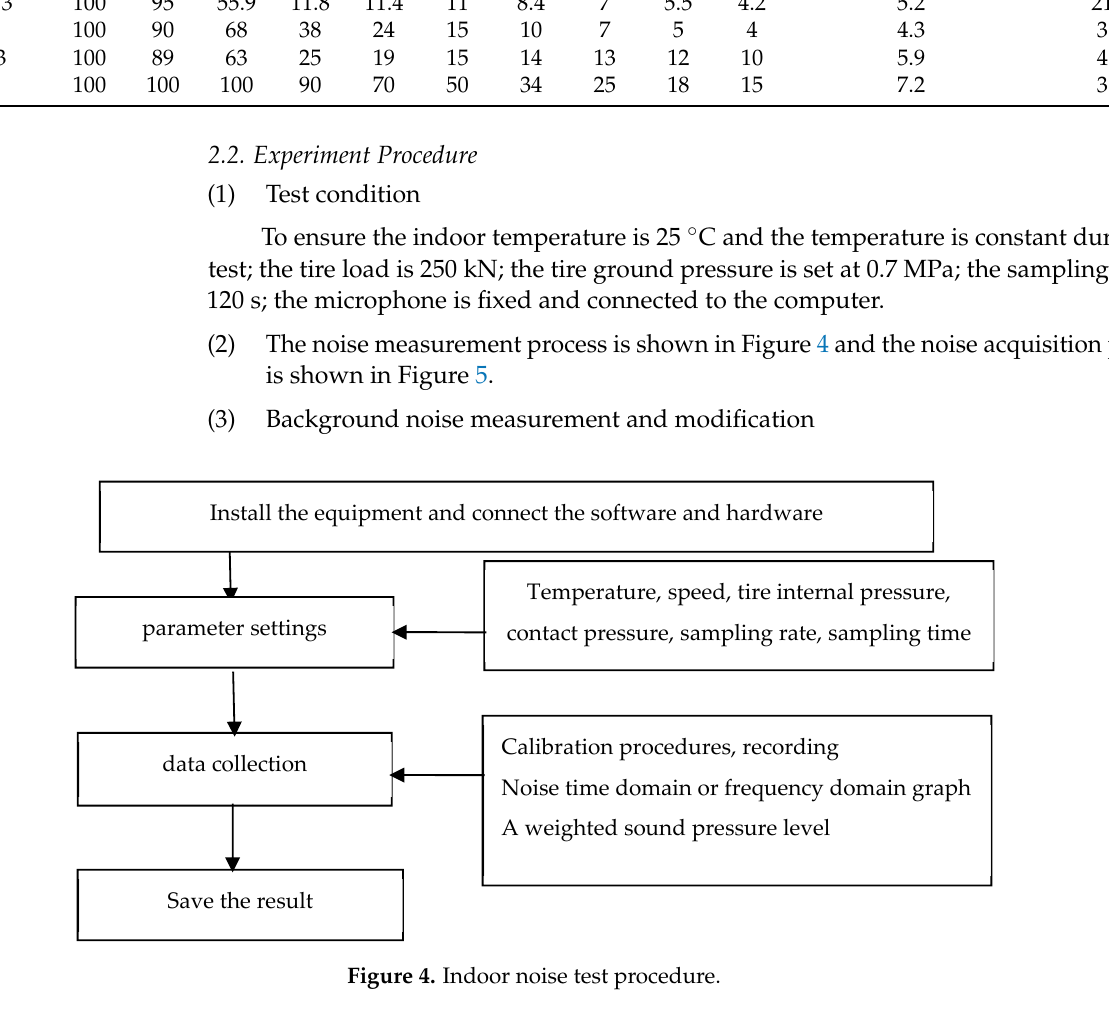
Figure 5. The noise acquisition process. (3) Background noise measurement and modification Before the test, make the driving wheel (that is, the tire) idling without contact with the surface of the test piece. The measured noise at the same position is the background noise, and the value measured in the test is 38.1 dB(A). In order to ensure the accuracy of pavement noise measurement, it is necessary to determine the background noise of the test system environment [34]. When the difference between the measurement noise and the background noise is more than 10 dB(A), the background noise can be ignored; when the difference is between 6 and 10 dB(A), the measurement noise should be corrected, and the measurement result should be subtracted from the correction value in Table 7; when the difference is less than 6 dB(A), the meas- urement is invalid. Table 7. Background noise correction value. Difference Between the Measurement Noise and the Background Noise/dB(A)